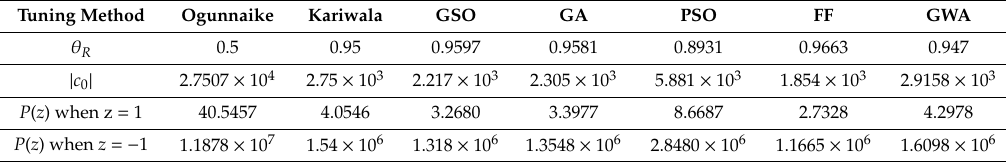
Table 10. Example 1: Jury’s stability test for liquid level control ( c n = 5.1164e + 04 and θ ref =